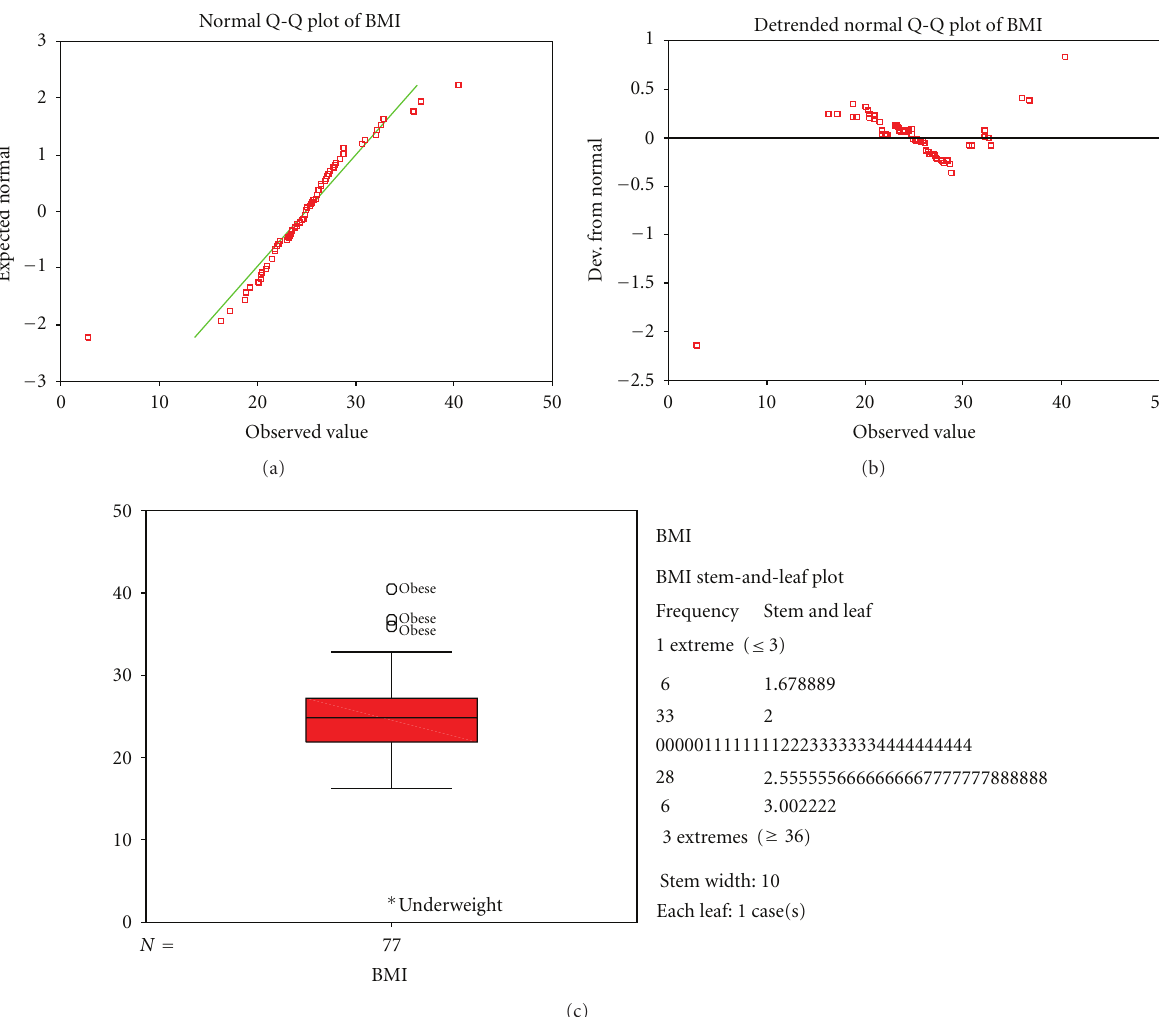
group had similar higher concentration of obese people